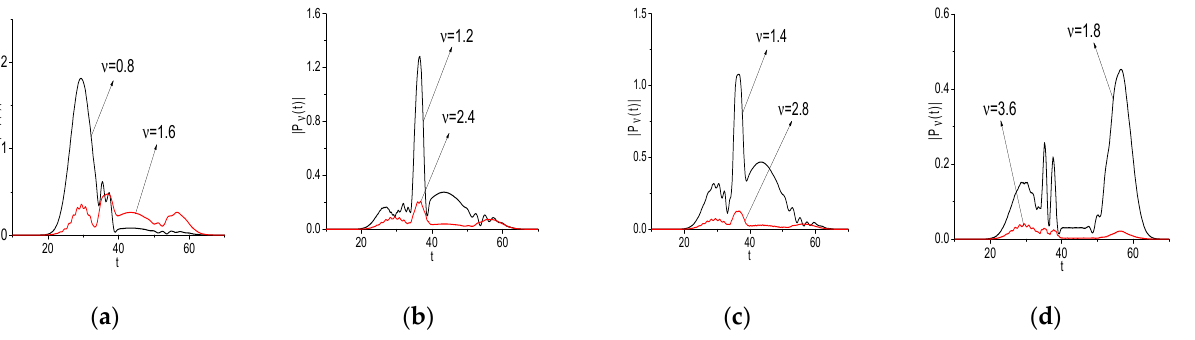
( 2 ) χ (2) = 0.1. Black lines correspond to the = 0.1. Black lines correspond to the dl dl ( ) E t . _ tran norm